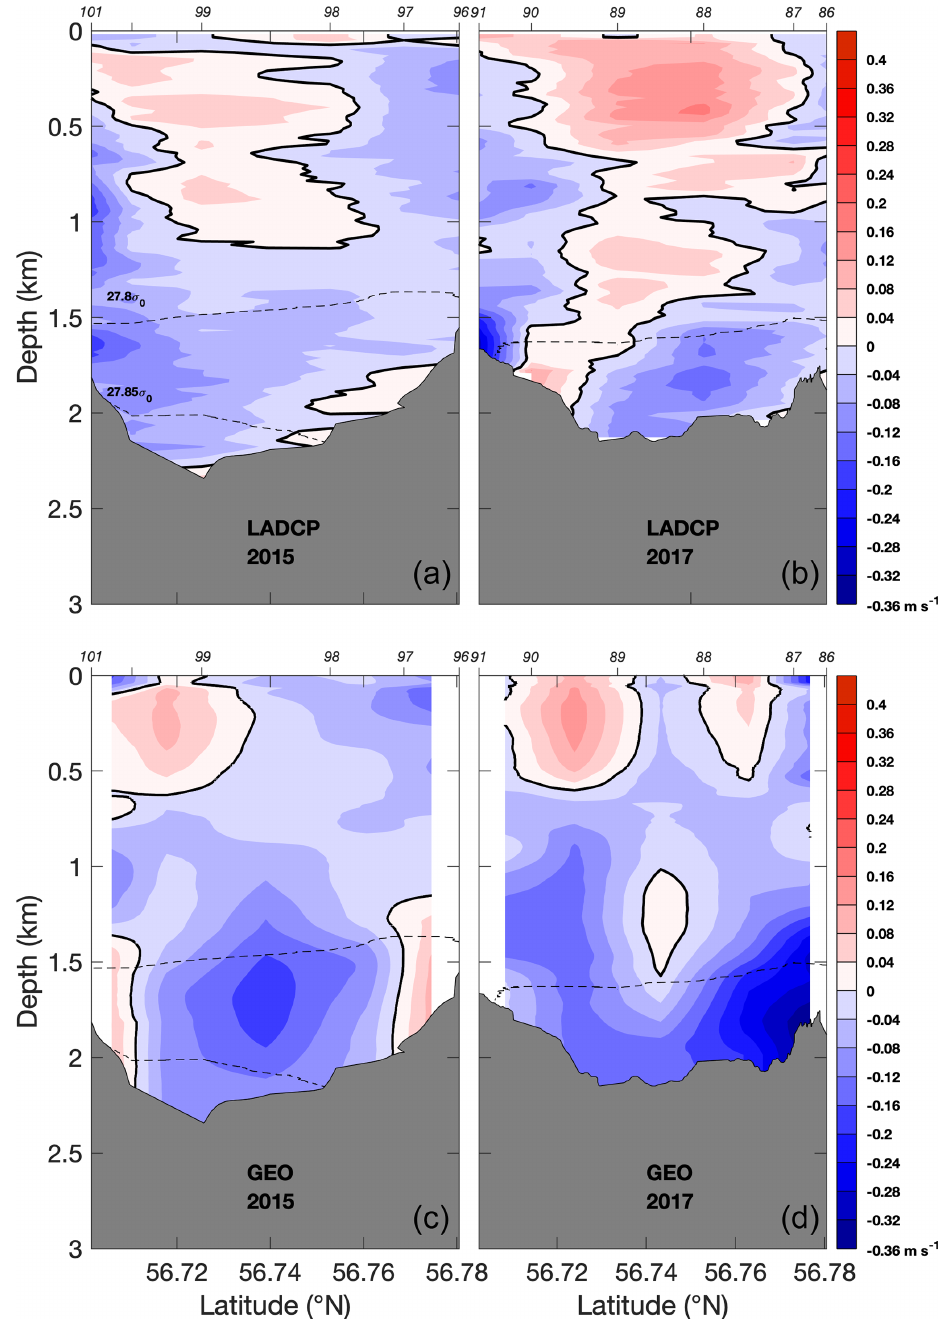
Figure A3. (a, b) L-ADCP and (c, d) geostrophic velocity sections along the East sections in 2015 and 2017 (ms − 1 ). Positive values correspond to eastward velocities. The black bold line outlines the 0 isotach. The dashed black lines indicate the potential density σ 0 = 27 . 52, 27.71, 27.8 and 27.85kgm − 3 . Bathymetries from the ship surveys are added in gray. Locations of the hydrographic stations are indicated on the top